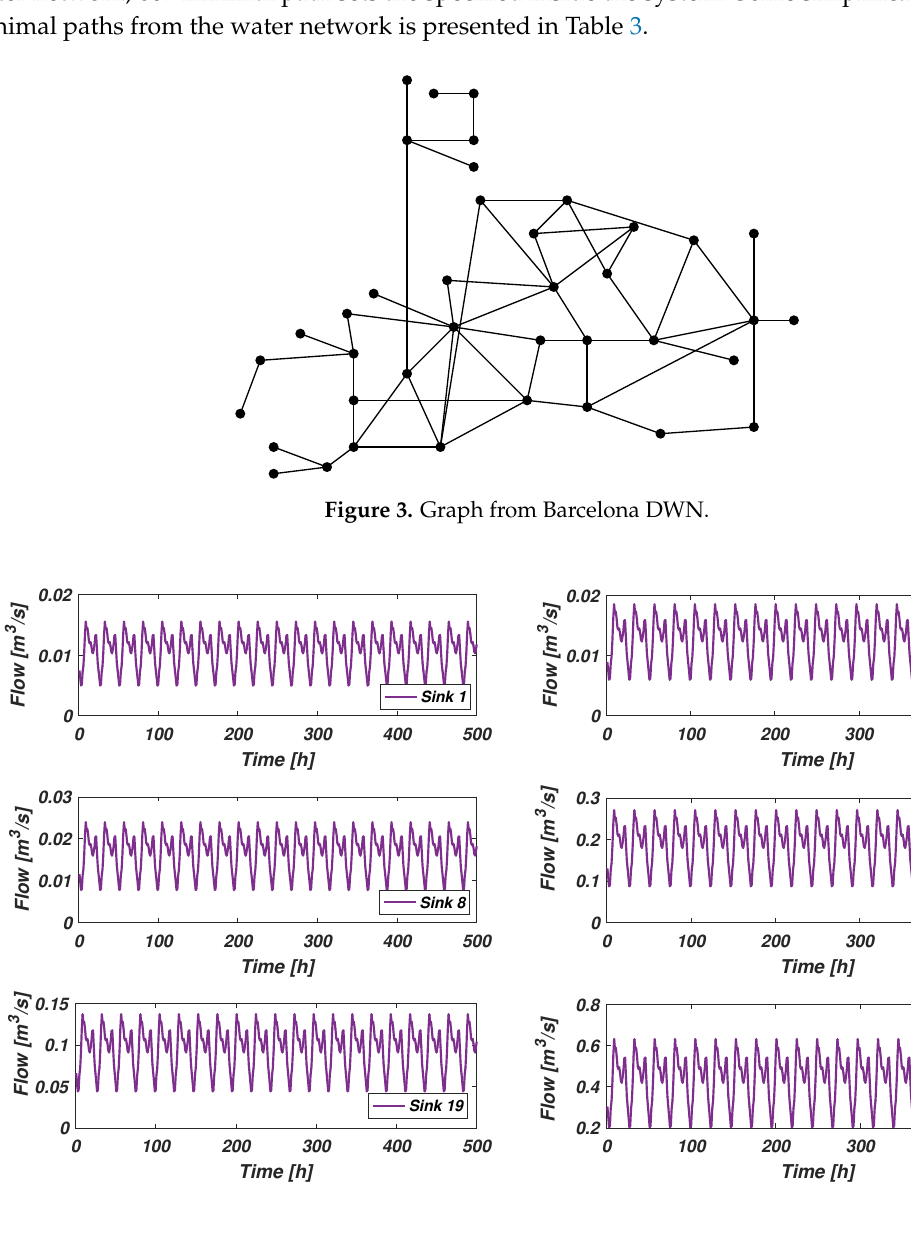
Figure 4. Drinking water demand for several